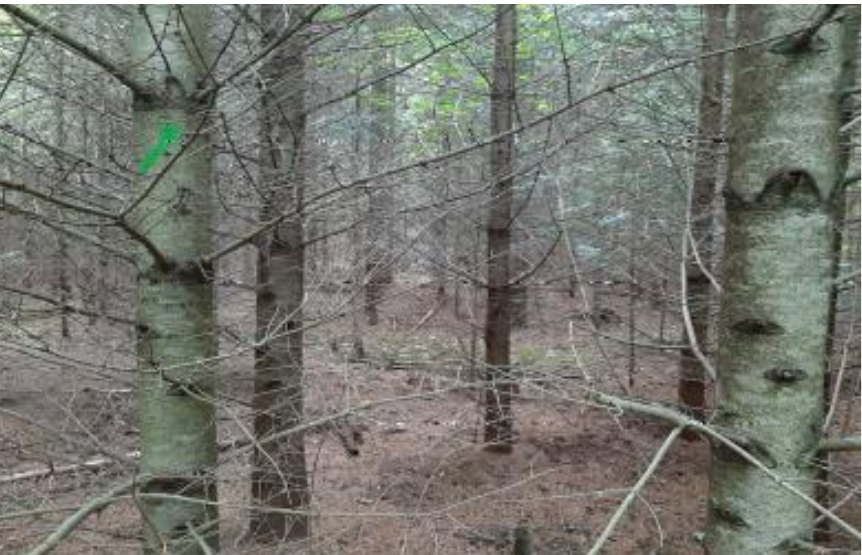
Figure 7. Silver fir, which was lagging in growth in 2015 (it was then marked in green, which means an initial assignment for harvest, but not felled). Compare this fir in 2021 to neighboring trees that were not assigned for felling 6 years ago (photo by A. Marozau).